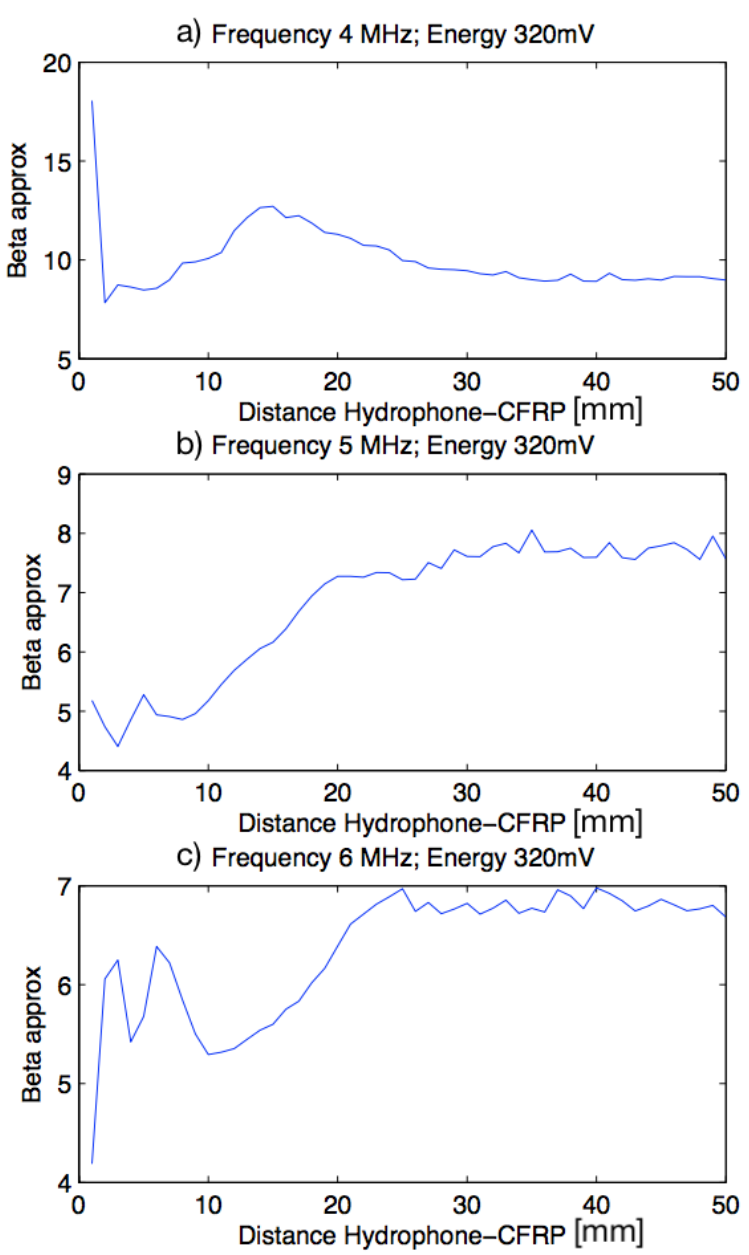
Figure 12. Plots beta versus distance specimen-hydrophone. ( a ) Frequency of 4 MHz and Energy of 320 mV; ( b ) Frequency of 5 MHz and Energy of 320 mV; ( c ) Frequency of 6 MHz and Energy of 320